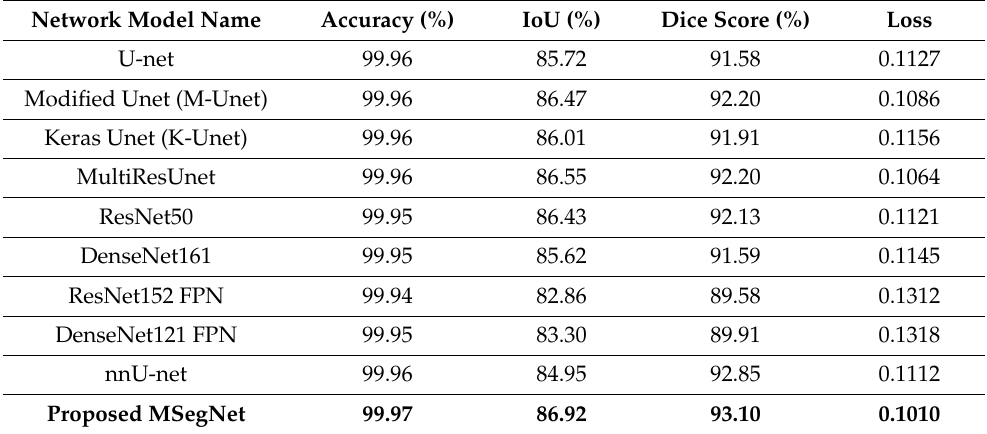
Table 6. Performance evaluation matrices of all segmentation models. Bold represents the best performing model.